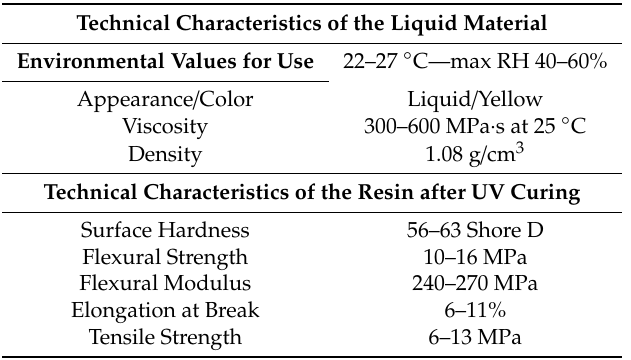
Table 2. Characteristics of photopolymer FUSIA 444 ®